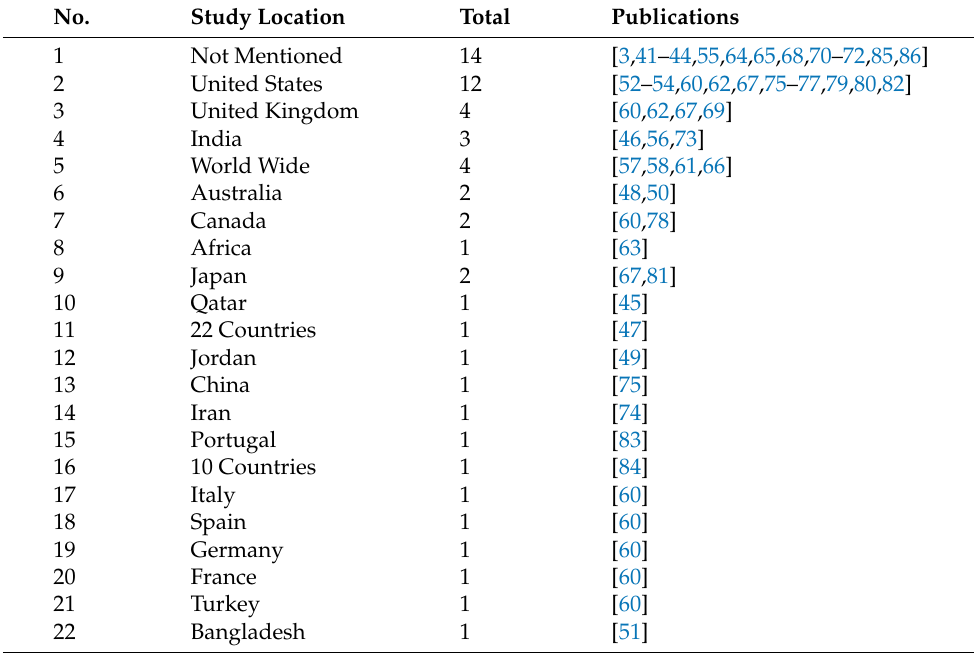
Table 7. Geographical locations of reviewed studies